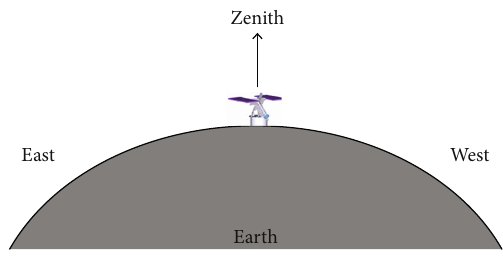
Figure 32: The panel is oriented towards the zenith.